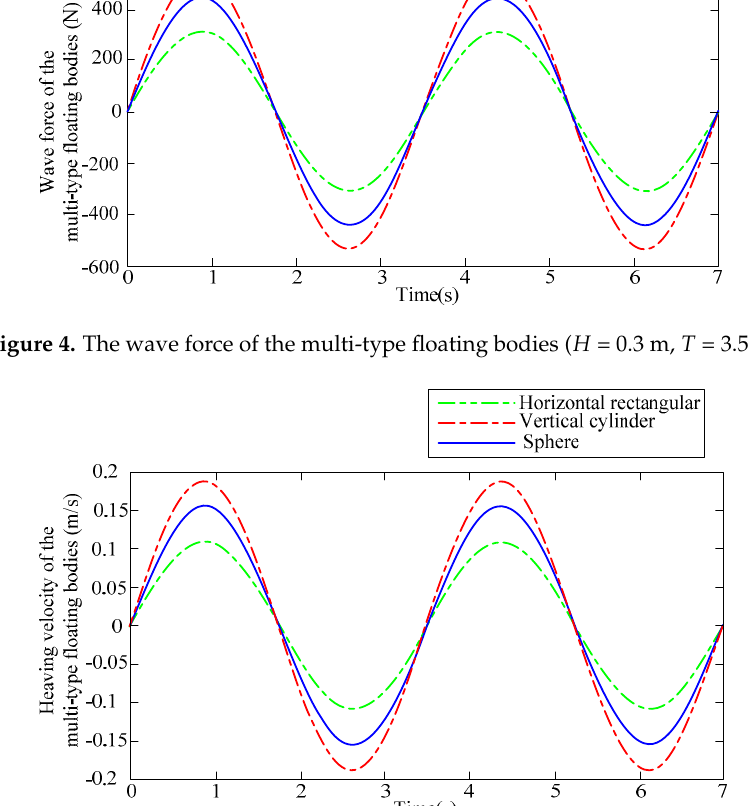
Figure 6. The heaving displacement of the multi-type floating bodies ( H = 0.3 m, T = 3.5 s). Figure 7. The capture width ratio of the multi-type floating bodies ( H = 0.3 m, T = 3.5 s).